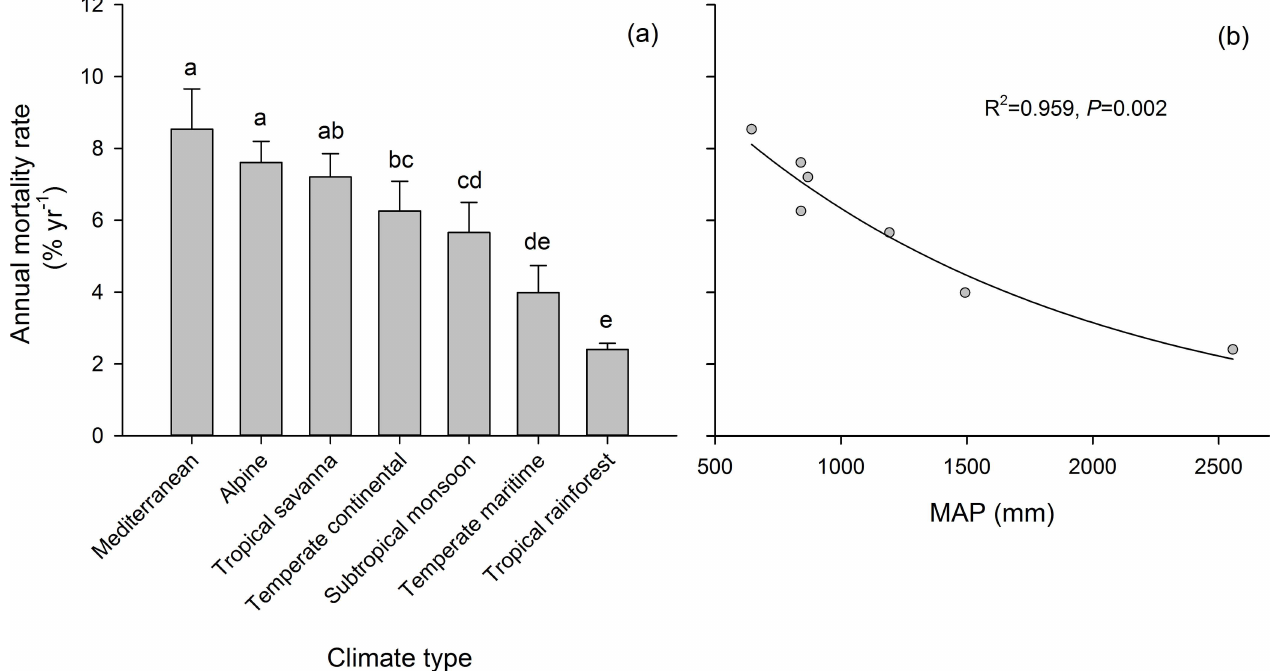
Fig 1. (a) Annualmortality rates for the climatic types. Significant differencesbetweenthe annualmortality rates of the climatic types are labelled with different lowercaseletters ( P < 0.05). Valuesrepresent the mean ± SE. (b) Relationship betweenannualmortality rate and mean annual precipitation (MAP).